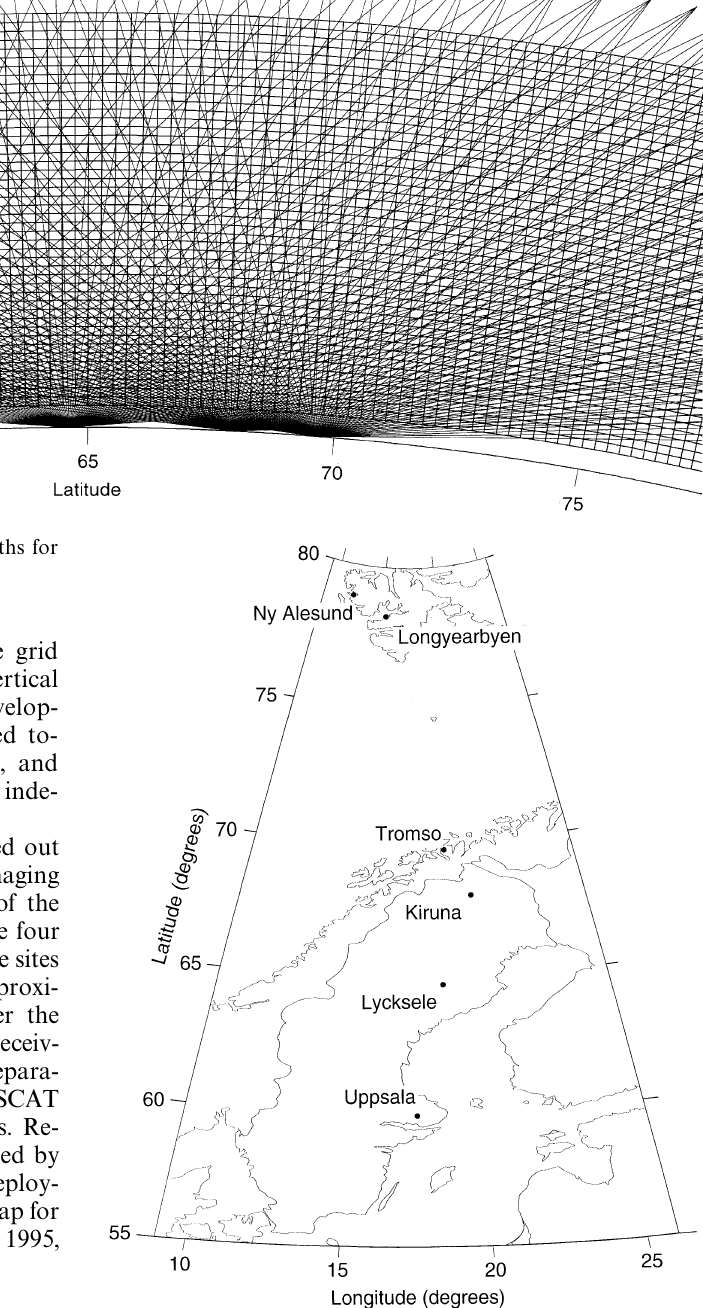
Fig. 2. Map showing the location of receiving stations used in Scandinavia